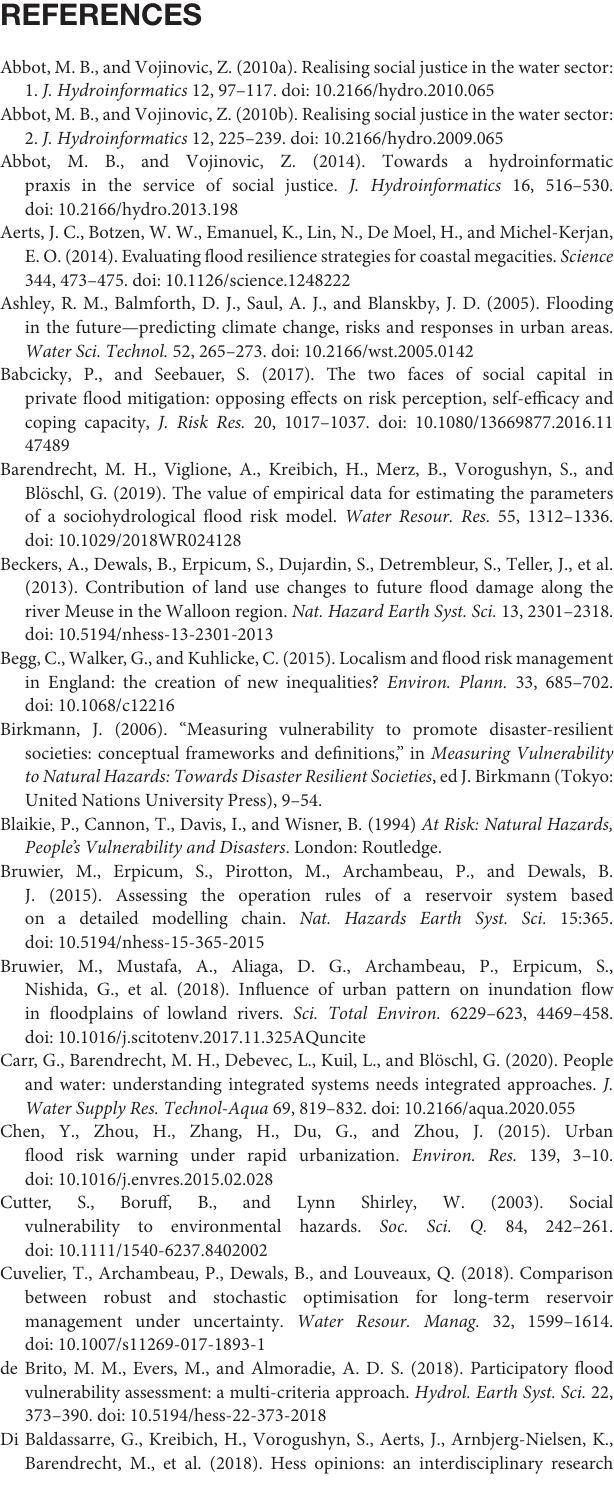
Supplementary Figure 2 | (A) Distribution of households as a function of their ISD class, in each district and in flood-prone areas defined by to different ranges